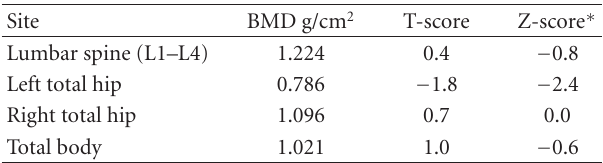
Table 1: The results of the DXA scan are outlined below. Note the 2.5 SD di ff erence between the left and right hip based on the T-score di ff erence (2.4 SD di ff erence on the Z-score).